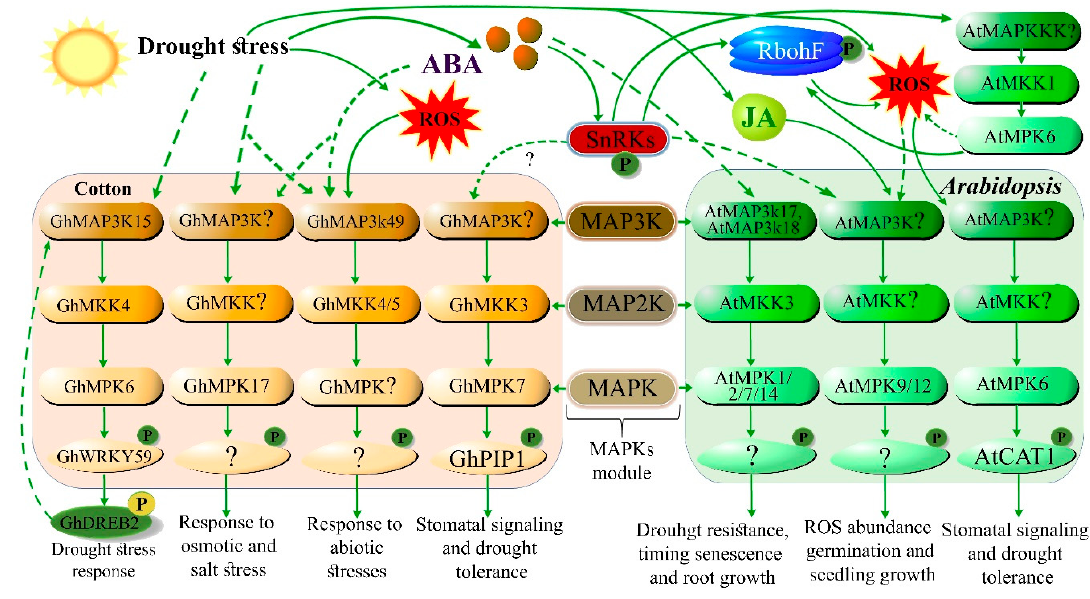
Figure 2. Drought-induced, ABA-dependent, ABA-independent MAPK signaling, and interaction between ABA, ROS, and MAPK signaling under drought stress in plants. ABA-regulates various MAPKs in cotton and Arabidopsis. ABA promotes drought sensing and signaling in plants. The different cascades are represented by different color schemes in the figure. Solid arrow lines denote established signaling mechanisms, while dashed arrow lines denote unestablished signaling pathways. ABA-activated SnRK2s (See figure 1 for SnRK2 activation) trigger and phosphorylate downstream targets, such as respiratory burst oxidase homolog (RBOH) and various MAPKs.